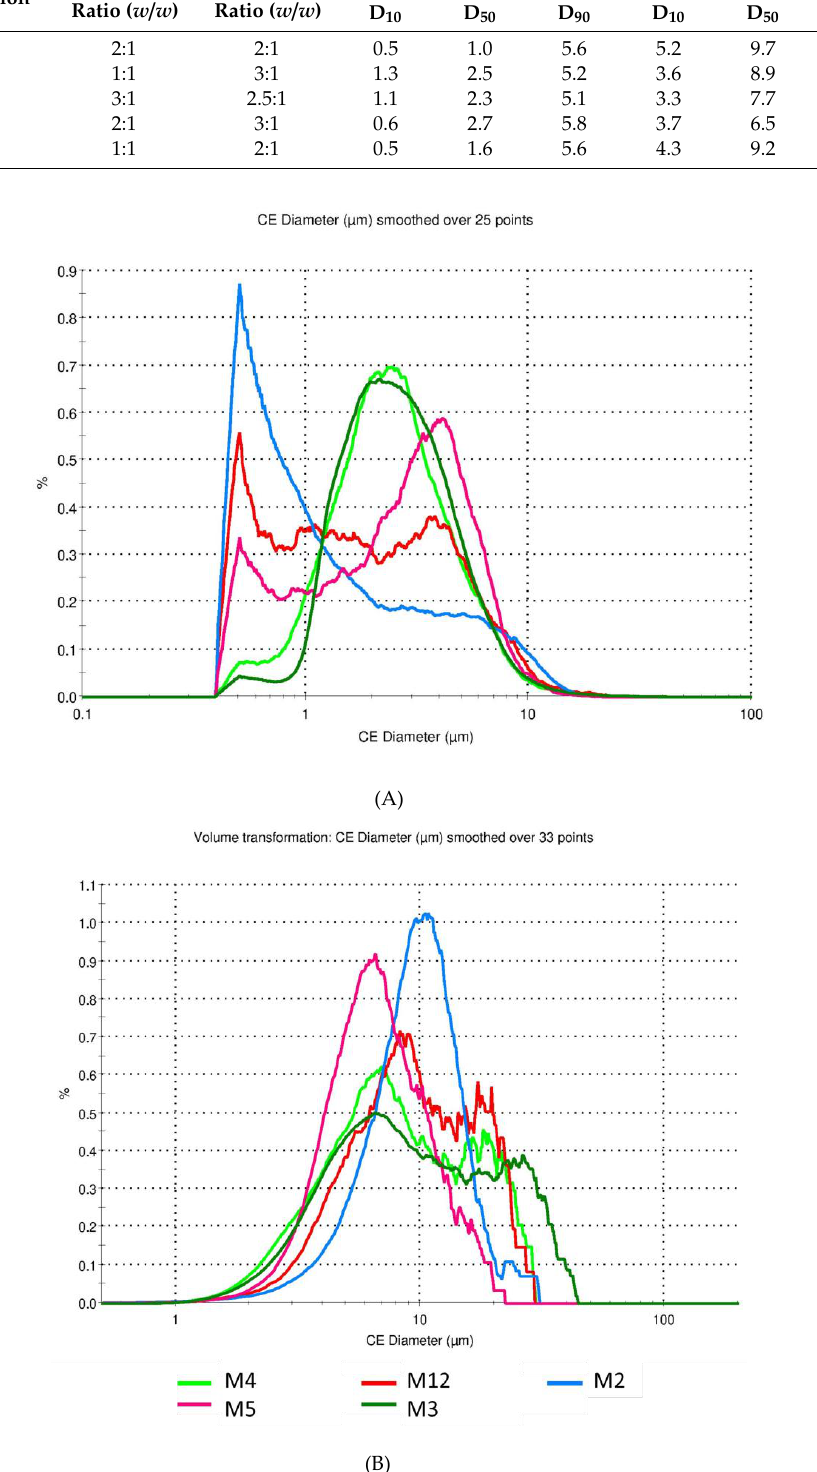
Figure 4. Number ( A ) and volume ( B ) size distribution of the selected gCS/CF microparticles with zidovudine.